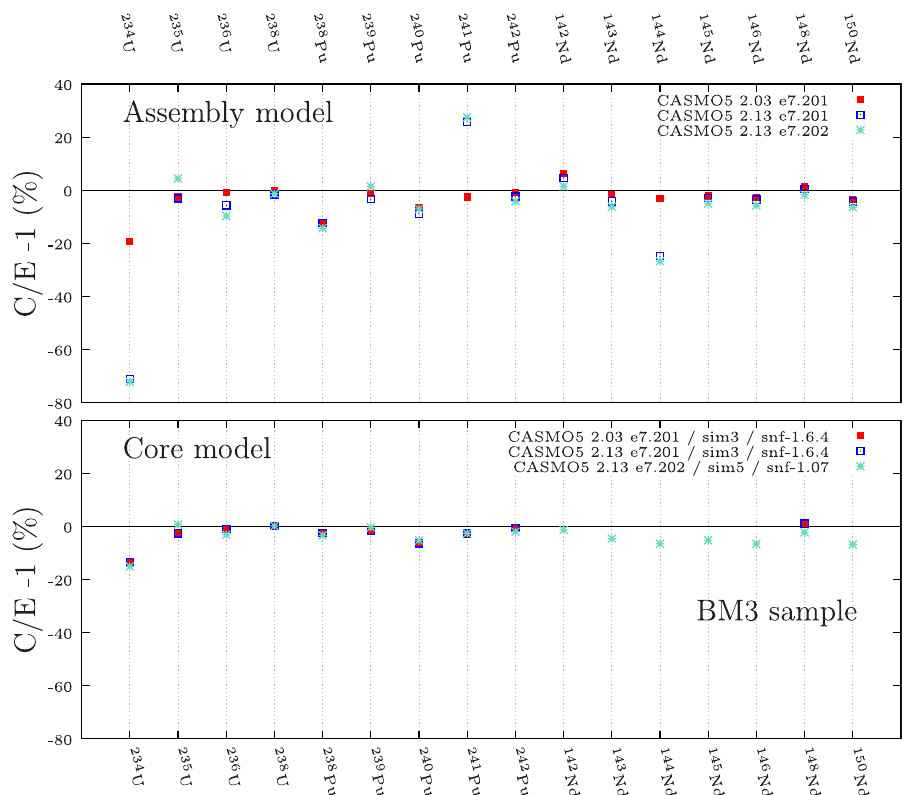
Fig. A.2. Comparisons between calculated and measured values (C/E–1) for each measured isotopes from different calculations for the BM3 sample (PSI measurements); top: CASMO5 calculation only, bottom: 3D-1